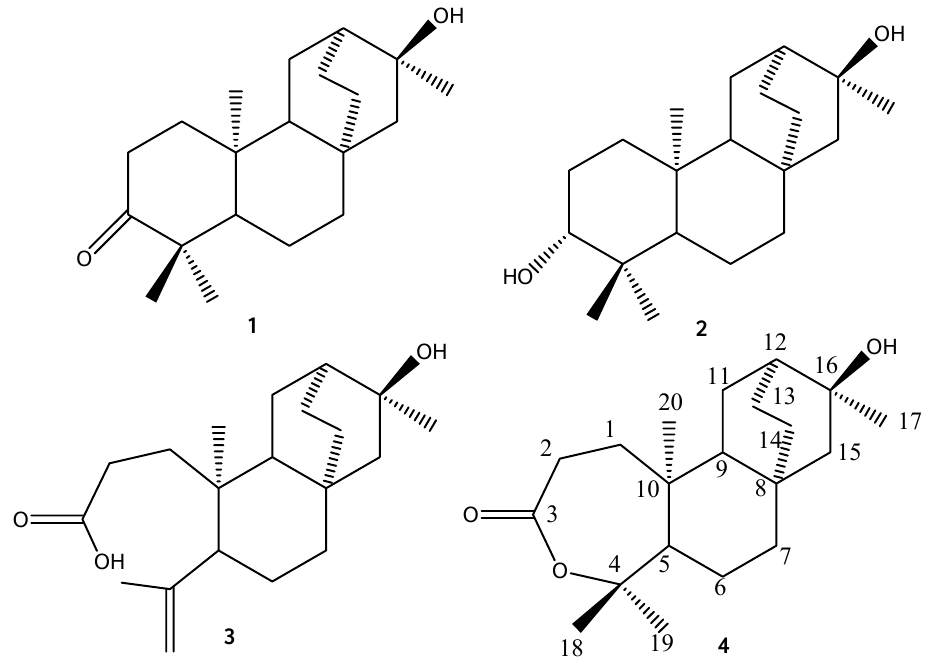
Figure 1. Structures of the compounds 1-4